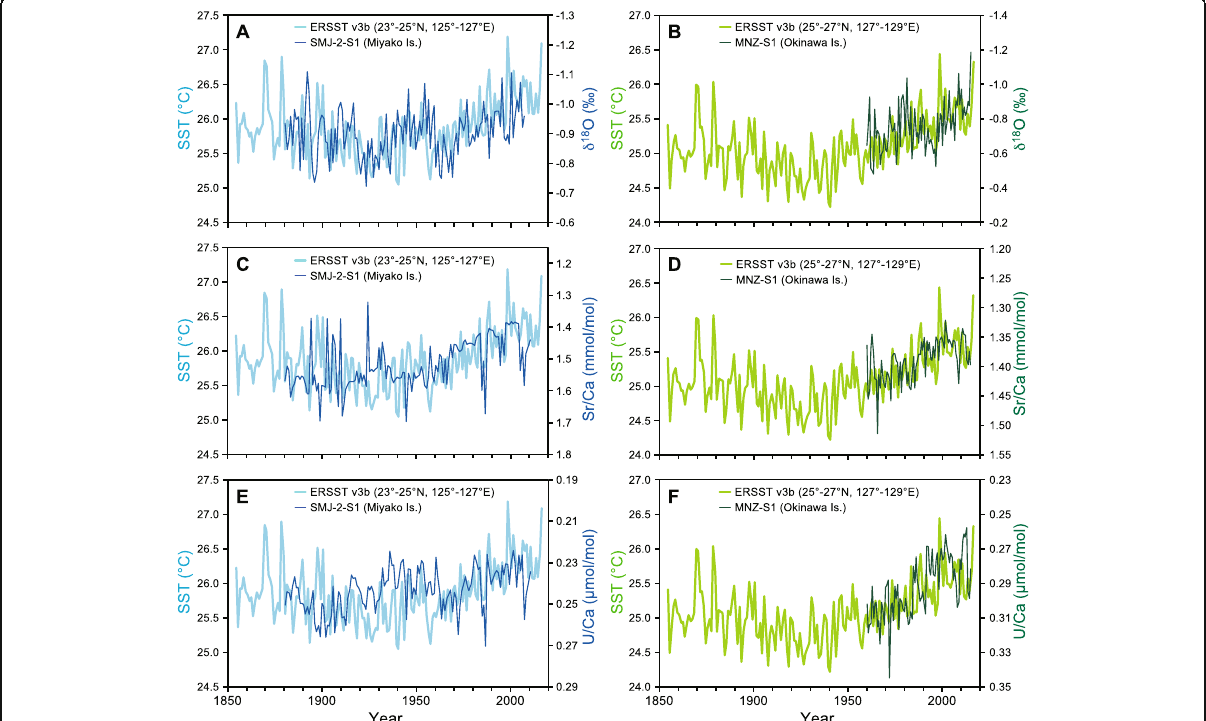
Fig. 7 Comparison of time series of sclerosponge δ 18 O ( A and B ), Sr/Ca ( C and D ), and U/Ca ( E and F ) from Miyako Island (left panels) and Okinawa Island (right panels) with instrumental SST for 1880 – 2016 (ERSST v3b,